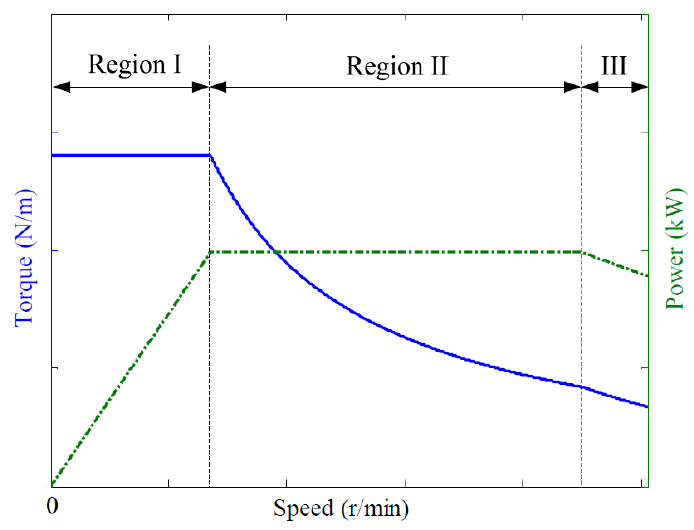
Figure 1. Characteristics of electric traction